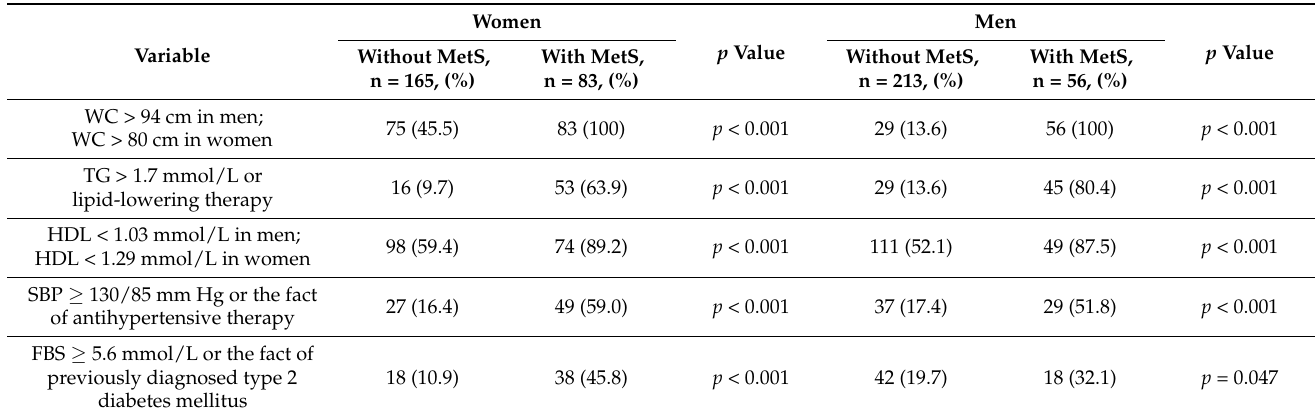
Table 2. The prevalence of individual components of the MetS in groups of women and men, depending on its